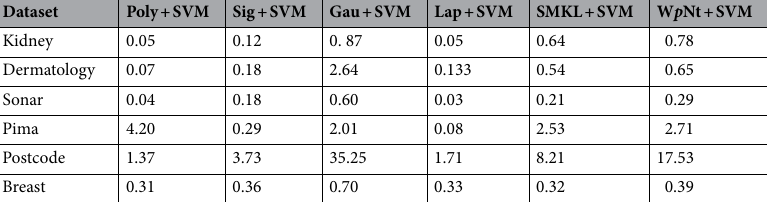
Table 6. The fivefold cross-validation classification training time based on the SVM algorithm with different kernel functions (minutes).